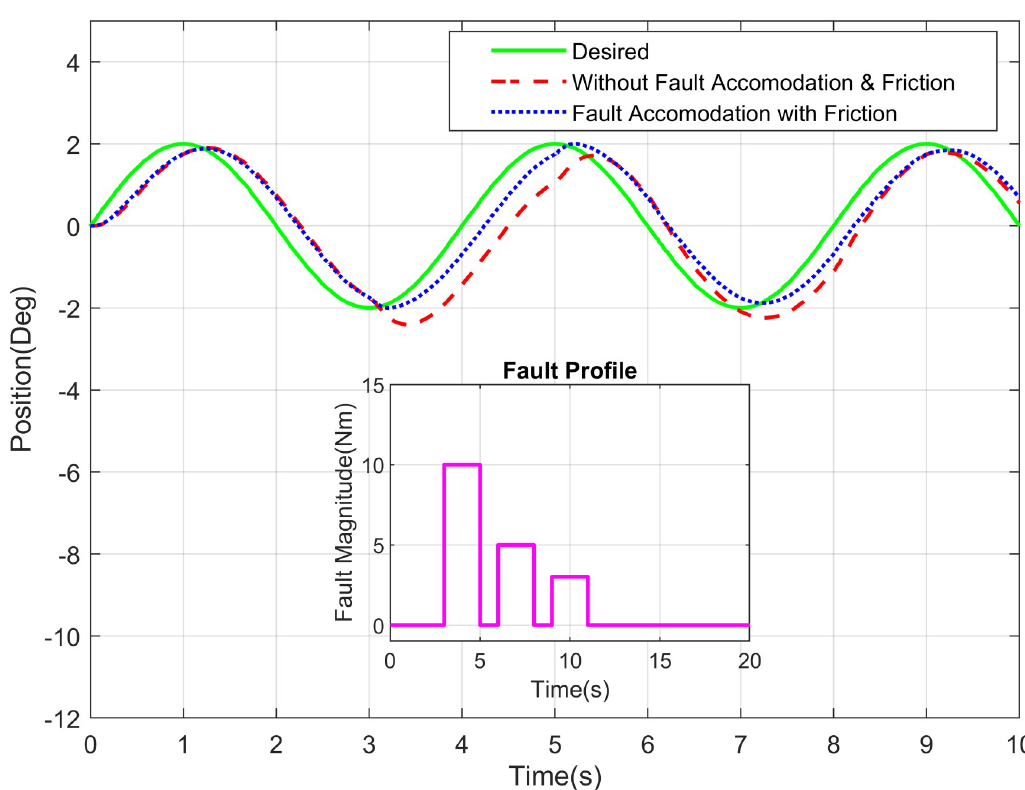
Fig 12. Sinusoidal response of elbow joint of a robot manipulator with intermittent fault profile.